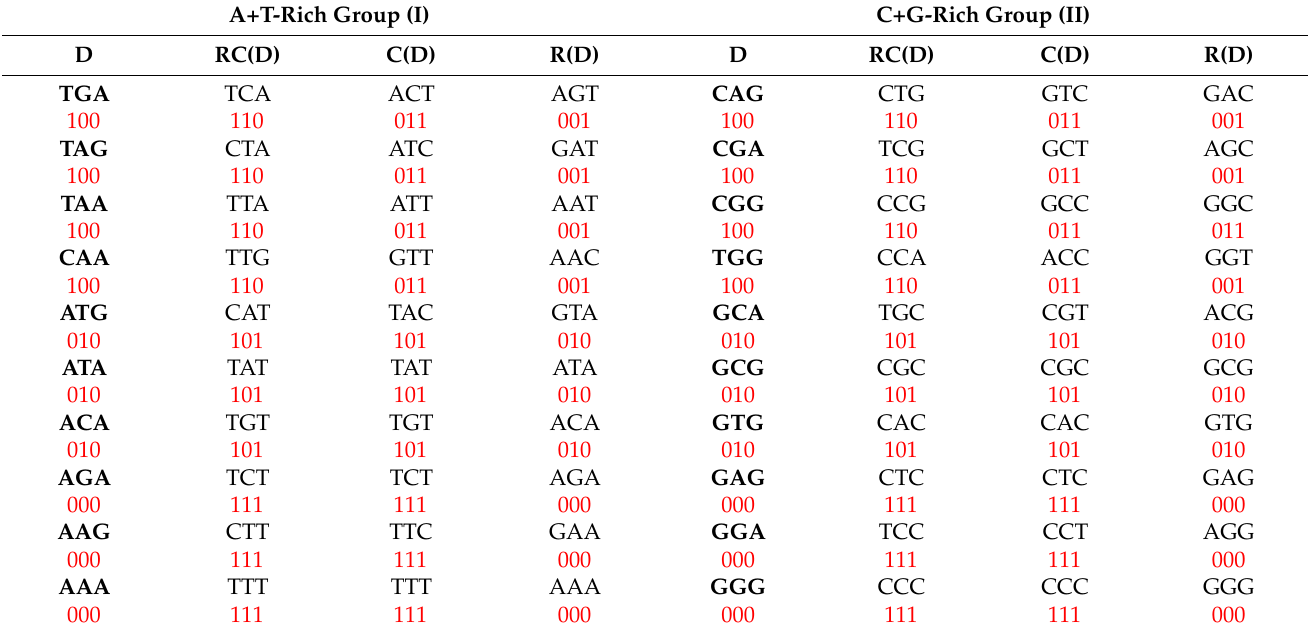
Table 1. Our novel quadruplet classification of all 64 possible trinucleotides. A quadruplet is a basic structure of a genome. Each quadruplet is unique and consists of nucleotides denoted as direct (D) , its reverse complement (RC), the complement (C) and reverse (R). The number 0 is assigned to purine, and 1 is assigned to pyrimidine. Trinucleotides have 10 A+T-rich and 10 C+G-rich quadruplets. The C+G-rich trinucleotides (group II) correspond to the purine–purine and pyrimidine–pyrimidine transformation of A+T-rich trinucleotides (group I). Within quadruplets, each member can be chosen as direct, and the other three can be arranged according to Watson–Crick pairing. Therefore, each quadruplet contains the same number of A and T as well as C and G bases, automatically satisfying CSPR. Quadruplets are ordered in rows, emphasizing purine–pyrimidine symmetry. C+G-Rich Group